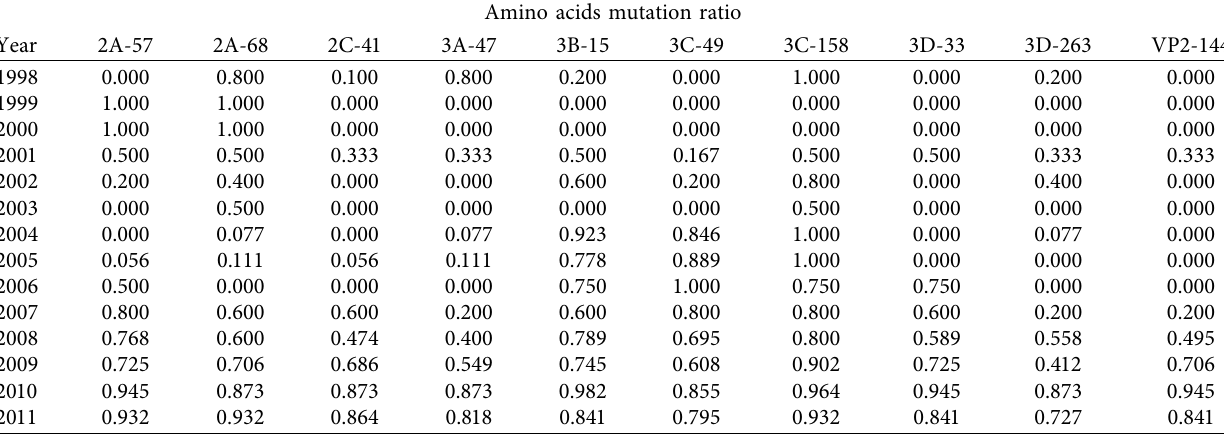
Table 4: Comparison of the amino acid substitutions in the Chinese EV-A71 strains in different